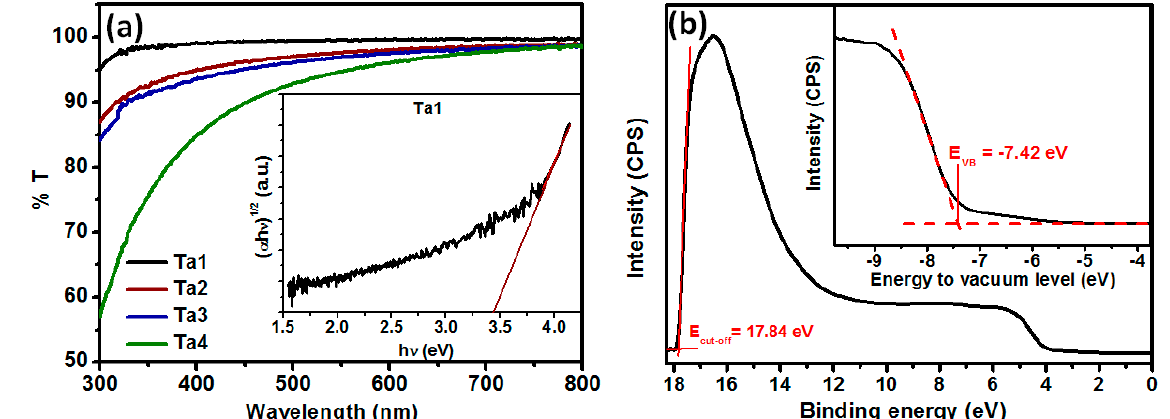
Figure 3. ( a ) Transmission spectra measured by UV–Vis spectrometry of Ta 2 O 5 films of thicknesses ~9 to ~19 nm; inset shows Tauc plot of Ta1 film. ( b ) UV photoelectron spectroscopy of Ta 2 O 5 film; inset shows the UPS spectrum in the valence band region.